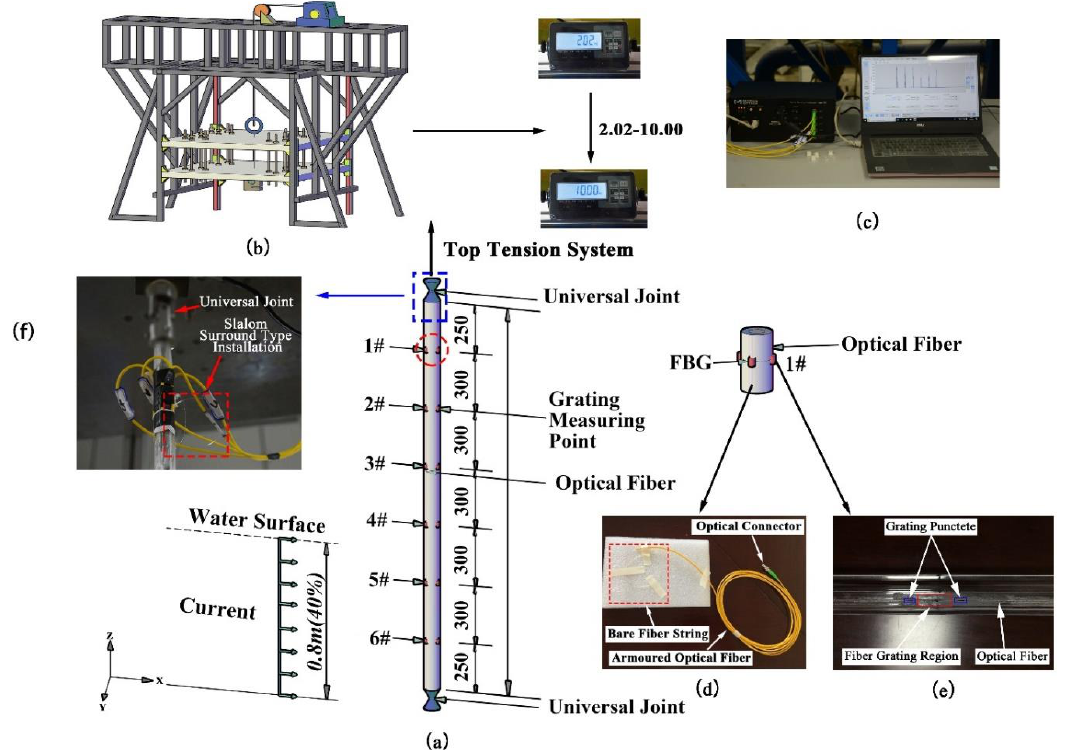
Figure 5. Layout of the top tension system and FBG sensors. ( a ) Riser model; ( b ) Control diagram of the top tension system; ( c ) FBG demodulator; ( d ) Bare fiber string and armored optical fiber; ( e ) Layout of FBG measuring points; ( f ) Installation of bare fibers.